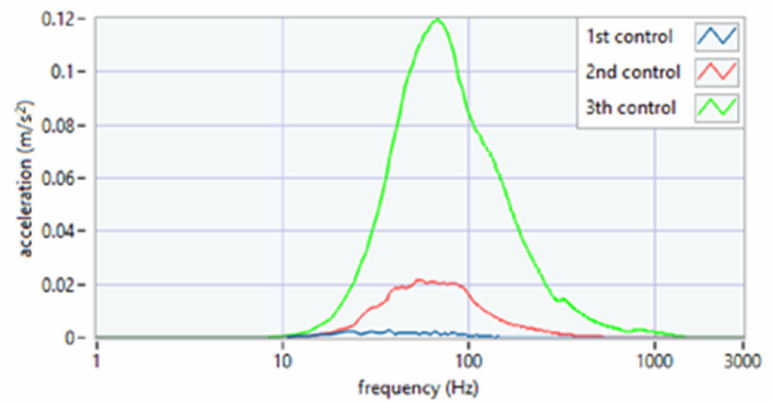
Figure 9. Average spectrum of slow opening (SO)—left side: 1st, 2nd, 3rd